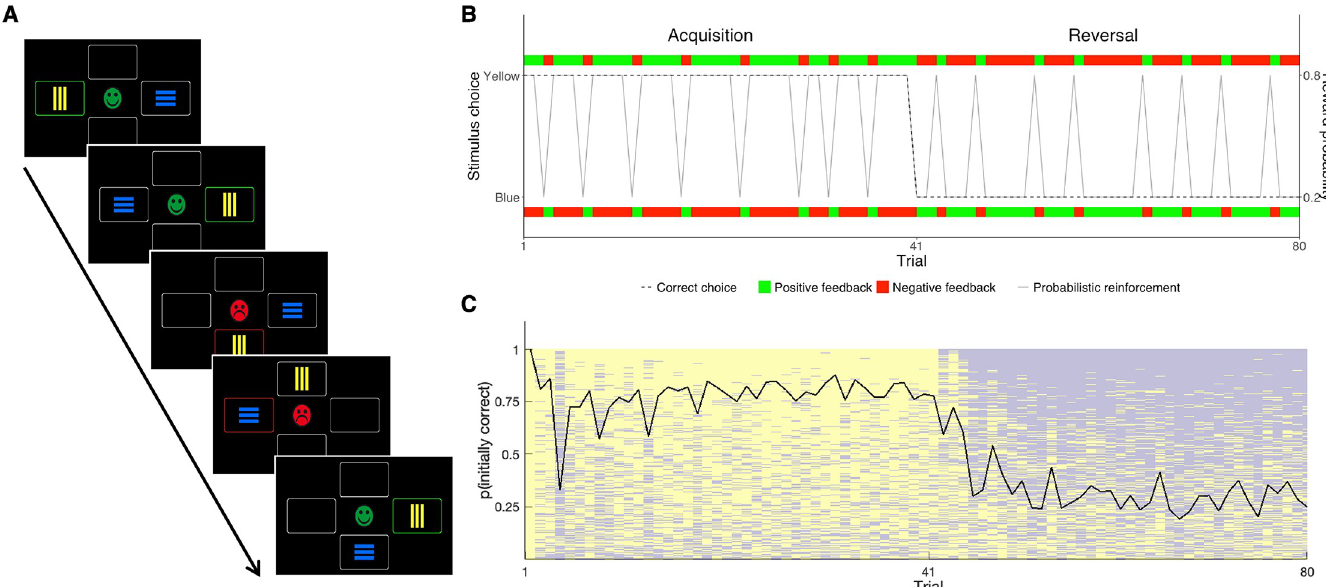
Fig 1. Task presentation and pooled task behavior. (A) An example of several consecutive trials—on each trial, participants have to choose between two stimuli, presented pseudorandomly in two of the four possible locations. Feedback is received in the form of a smiling green face (positive) or a sad red face (negative) and is probabilistic, meaning that some is “misleading” (e.g., trial 3). Win-stay trials are those in which individuals repeat their stimuli choice following positive feedback (e.g., trials 2 and 3), and lose-shift trials are those in which individual change their stimuli choice following negative feedback (e.g., trials 4 and 5). (B) The structure of the task —the first stimuli chosen by each participant is correct in the acquisition phase (trials 1–40; here: yellow). Feedback was given with an 80:20 reward/punishment ratio; green blocks indicate reward and red blocks indicate punishment. In the reversal phase (trials 41–80), the true correct stimulus is reversed (here: blue) as is the contingency schedule. (C) Overall trial-by-trial behavior—All participants’ data, sorted by performance, with average performance overlaid (black line) regardless of diagnosis or age group. Compare to (B) to see how task structure is experienced in practice (see S1 Data).